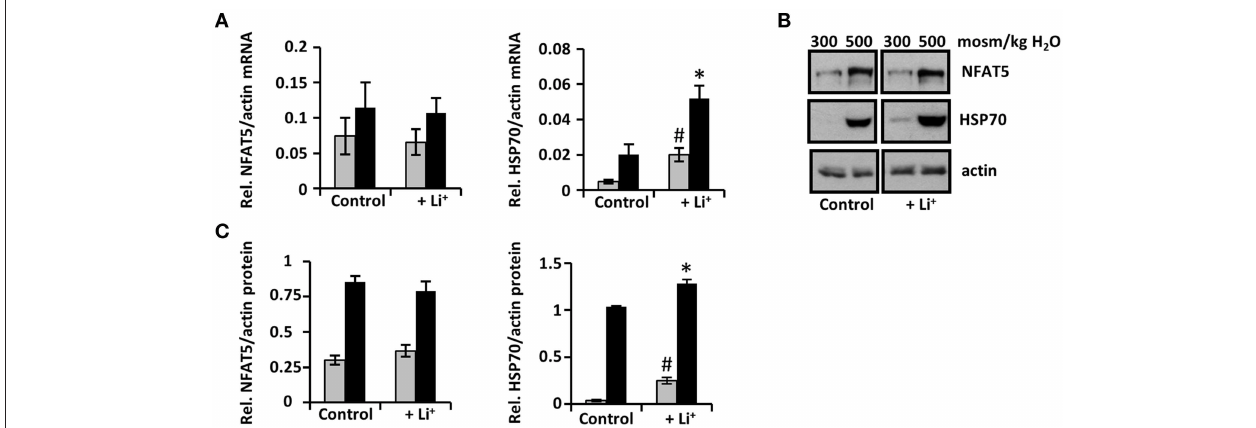
FIGURE 2 | Short-term exposure to lithium increases expression of the NFAT5 target gene HSP70. Confluent IMCD-3 cells were incubated for 24h in isosmotic ( ; 300 mosm/kg H 2 O) or hyperosmotic ( (cid:4) ; 500 mosm/kg H 2 O) medium and exposed to 10mM Li 2 SO 4 or 10mM Na 2 SO 4 (as control). (A) Cells were processed for RNA extraction and the abundance of NFAT5 and HSP70 mRNA transcripts determined by qRT-PCR. Relative mRNA abundance was normalized to that of β -actin to correct for differences in RNA input. Data are means ± SEM for n = 4 ; * P < 0.05 vs. hyperosmotic control; # P < 0.05 vs. isosmotic control. (B) Cells were processed for immunoblotting. To demonstrate comparable protein loading, the blots were also probed for actin. A representative blot from four independent experiments is shown. (C) Relative protein abundance of NFAT5 and HSP70 was quantified by densitometric analysis of immunoblots and normalized to that of actin to correct for differences in protein loading. Data are means ± SEM for n = 4 ; * P < 0.05 vs. hyperosmotic control; # P < 0.05 vs. isosmotic control.